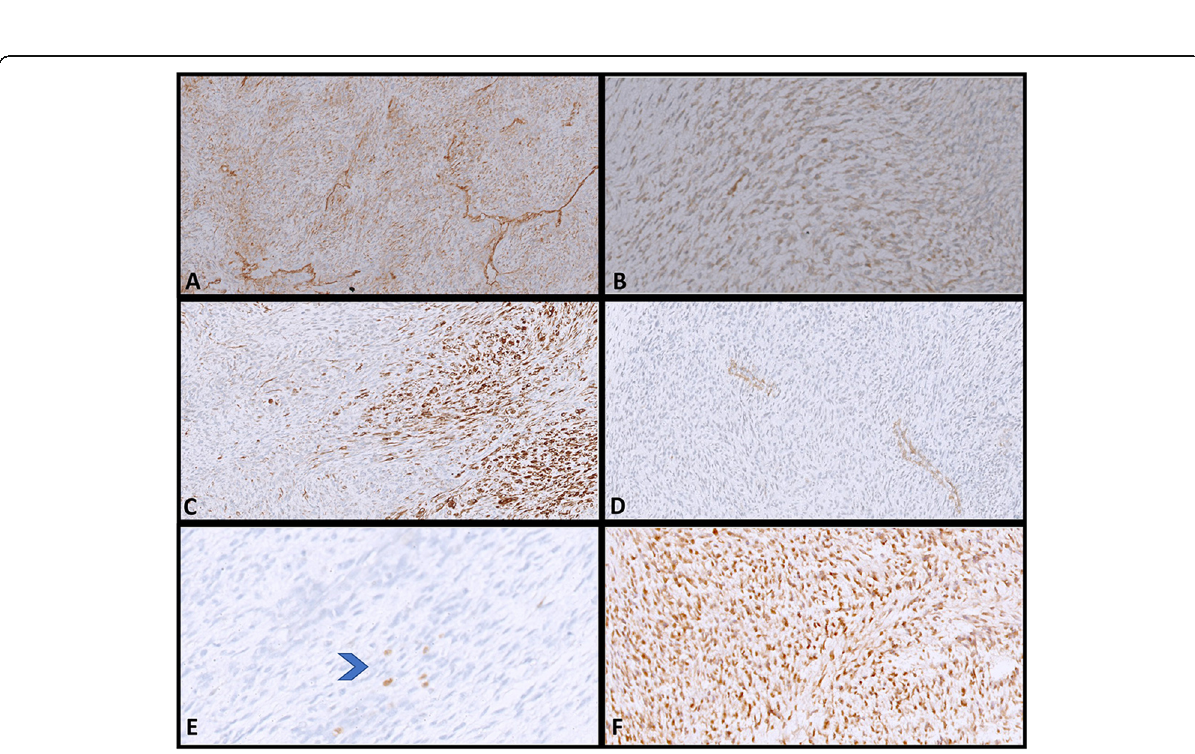
Fig. 3 Tumour cells showed diffuse immunopositivity for CD34, which had also highlighted staghorn vasculatures ( A DAB; 200x), Weak staining for BCL-2. ( B DAB; 200x). Besides focal immunostaining for desmin ( C DAB; 200x) was noted, however, SMA was negative (( D DAB; 200x). Occasional cells were also positive for S-100 protein. (Arrow) ( E DAB; 400 x) Strong and diffuse nuclear staining for STAT6 confirmed diagnosis of SFT( F DAB;